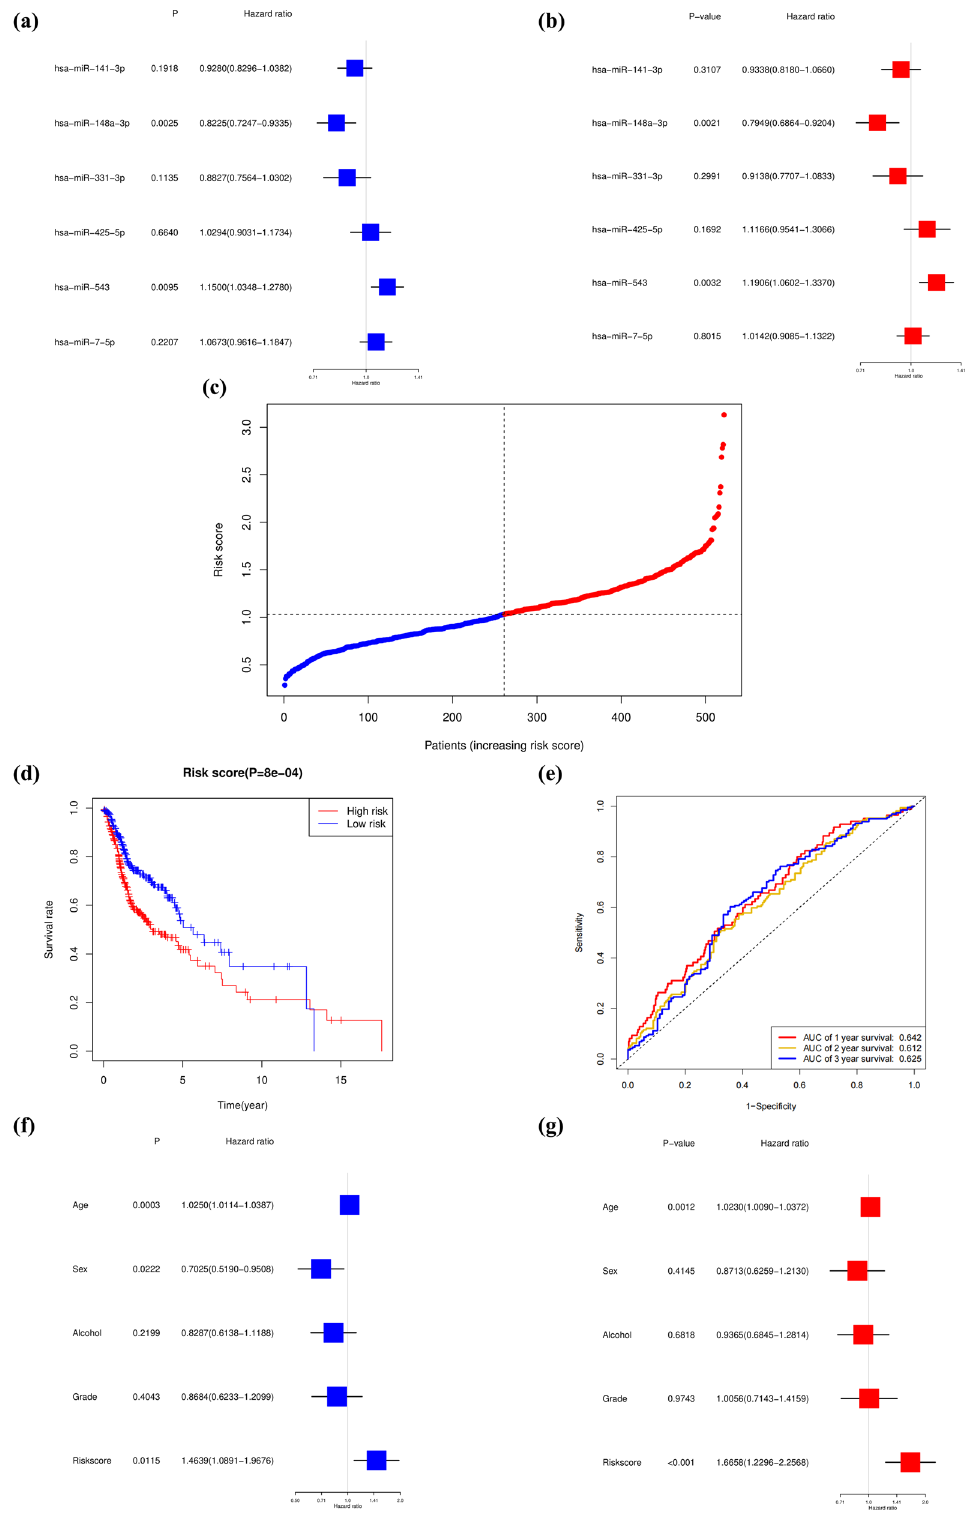
Figure 1: Construction of risk signature based on necroptosis - related miRNAs. ( a ) A univariate Cox regression analysis of OS for each necroptosis - related miRNA. ( b ) A multivariate Cox regression analysis of OS for each necroptosis - related miRNA. ( c ) Distribution of patients based on the risk score. ( d ) The Kaplan – Meier curve showed that the OS of the high - risk group was lower than that of the low - risk group. ( e ) The results of the ROC curve show that the model has an e ff ective prediction ability. ( f ) Univariate analysis revealed that risk score was related to OS. ( g ) Multivariate analysis indicated that risk score was an independent prognostic factor for